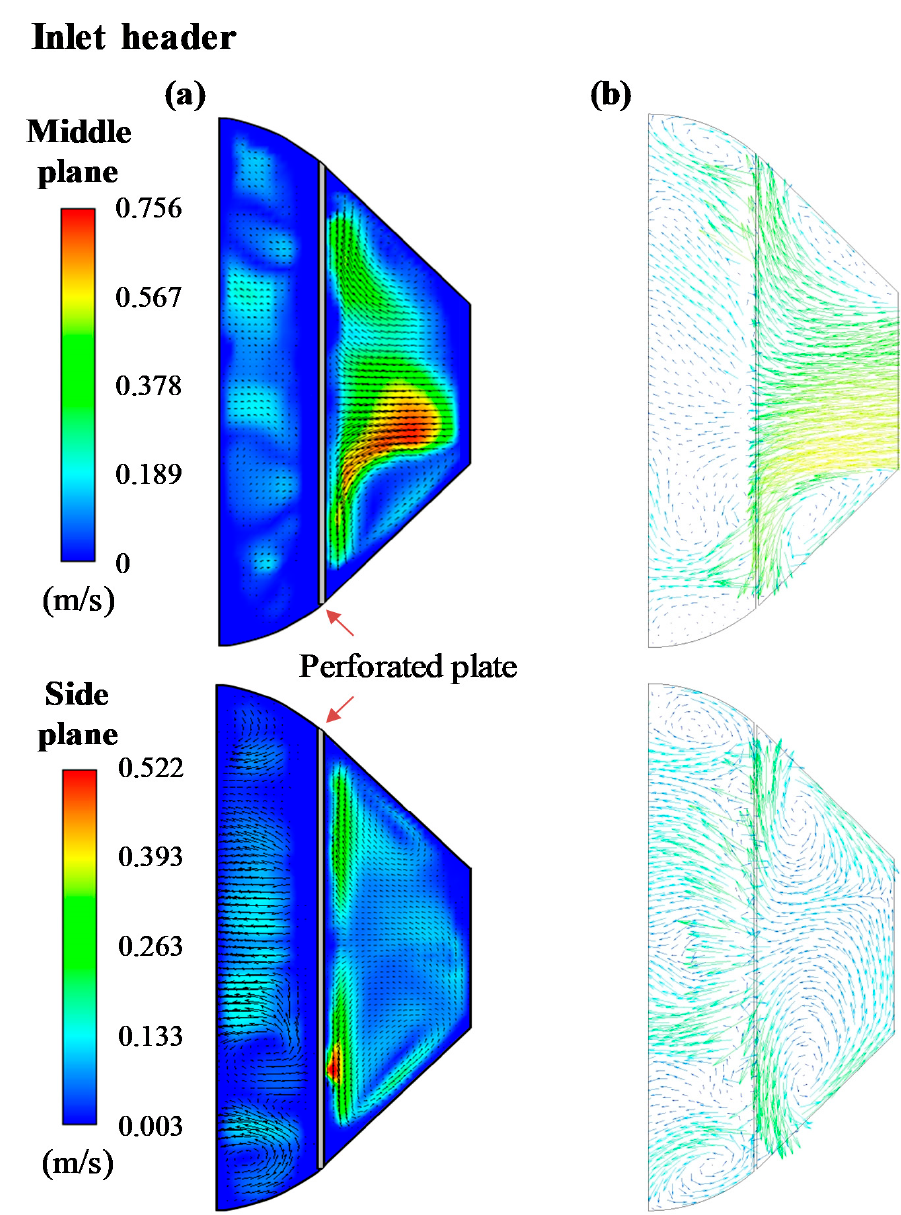
Figure 14. Velocity fields and contours in the inlet header when the perforated plate is installed: ( a ) experiment and ( b ) numerical simulation.